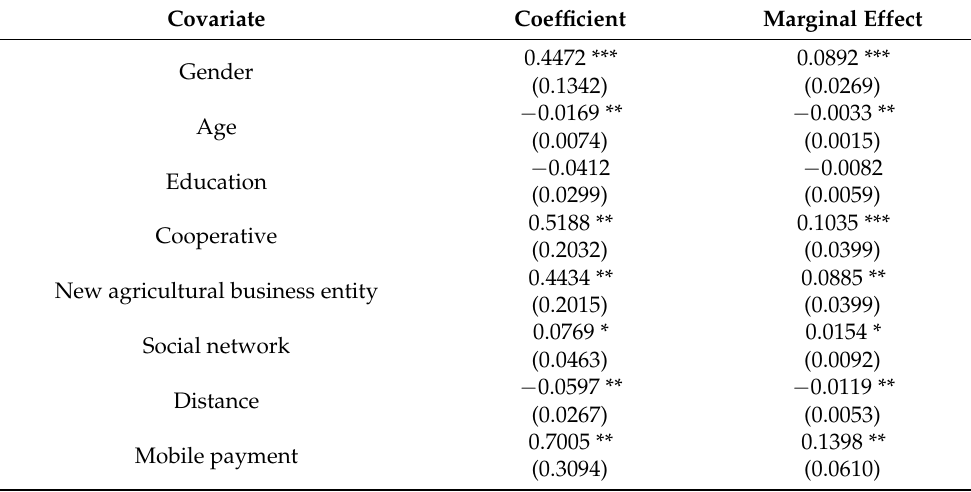
Table A2. Estimation of formal credit participation decision model (logit